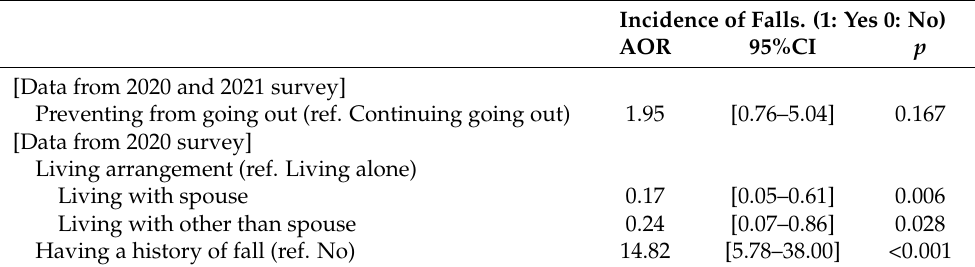
Table 4. Factors of incident of falls; multivariate logistic regression analysis (n = 237).